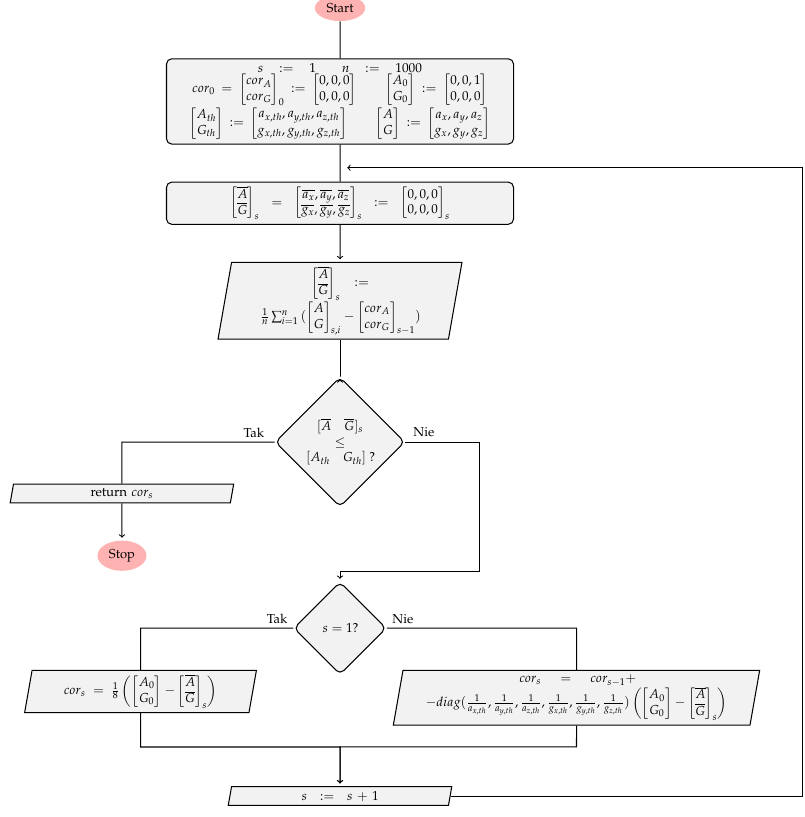
Figure 11. Diagram of the IMU initialization routine.